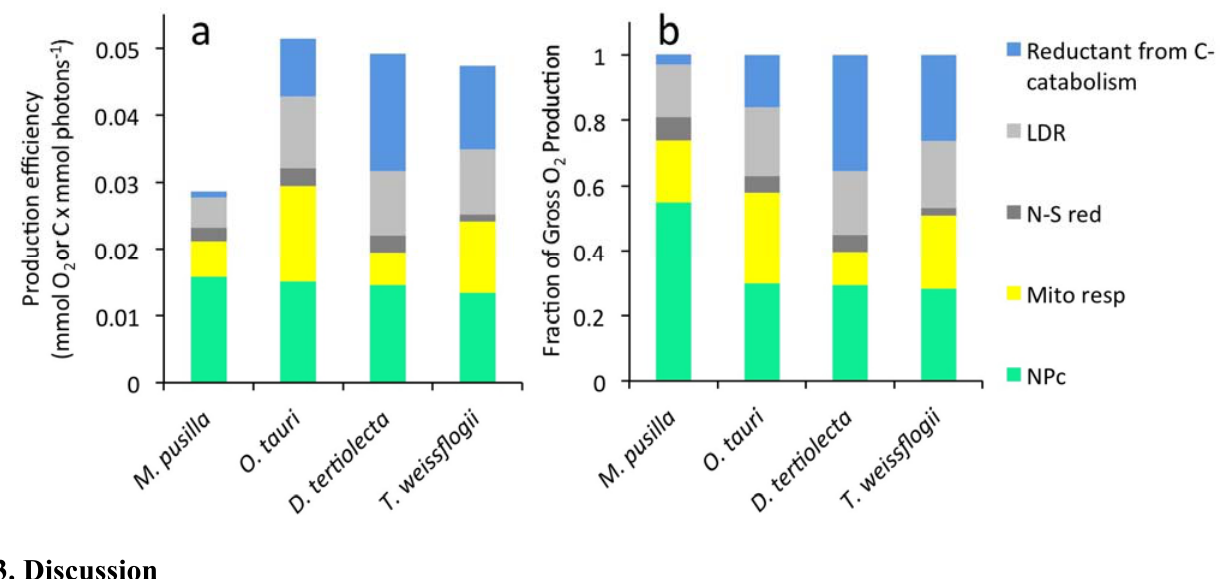
Figure 3. ( a ) Photosynthetic electron allocation to major metabolic sinks whose sum is GP O2* . For all four algal species, data are shown for cells growing at 1.0 d − 1 . Photosynthetic energy allocated to each of five metabolic sinks. ( b ) Fraction of gross photosynthesis (GP allocated to the five metabolic sinks. Note that data shown for D. tertiolecta and